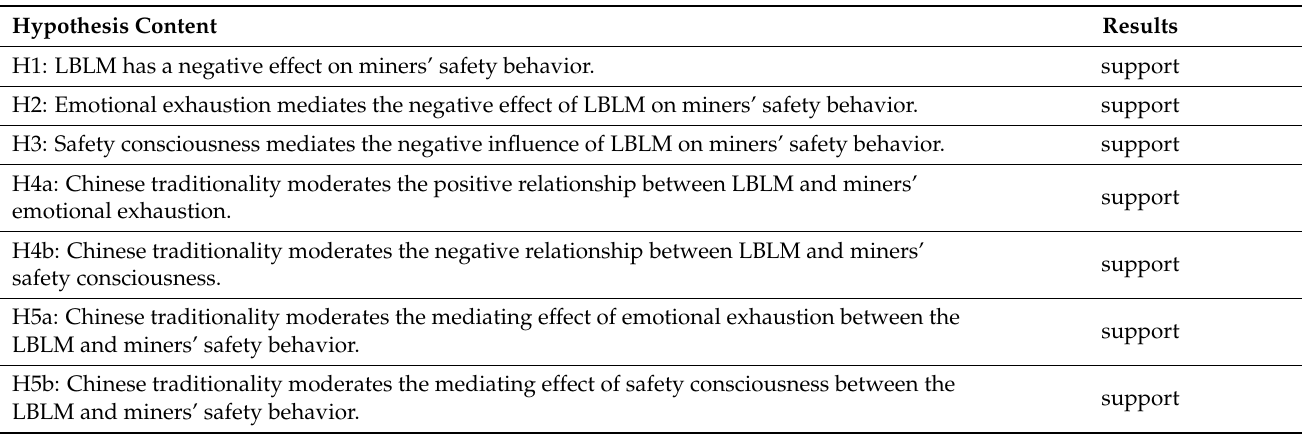
Table 8. Summary of hypothesis testing